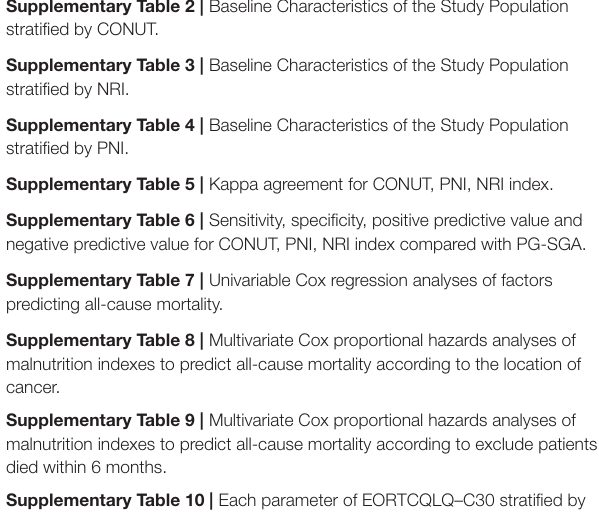
Supplementary Table 11 | Each parameter of EORTCQLQ–C30 stratified by NRI. Supplementary Table 12 | Each parameter of EORTCQLQ–C30 stratified by PNI. Supplementary Table 13 | Each parameter of EORTCQLQ–C30 (with ECOG less than 2) stratified by CONUT. Supplementary Table 14 | Each parameter of EORTCQLQ–C30 (with ECOG less than 2) stratified by NRI. Supplementary Table 15 | Each parameter of EORTCQLQ–C30 (with ECOG less than 2) stratified by PNI. Supplementary Table 16 | Hazard risk for all-cause mortality in elder patients treated with immunotherapy. Supplementary Figure 1 | Flow chart. Supplementary Figure 2 | Correlation analysis of clinical